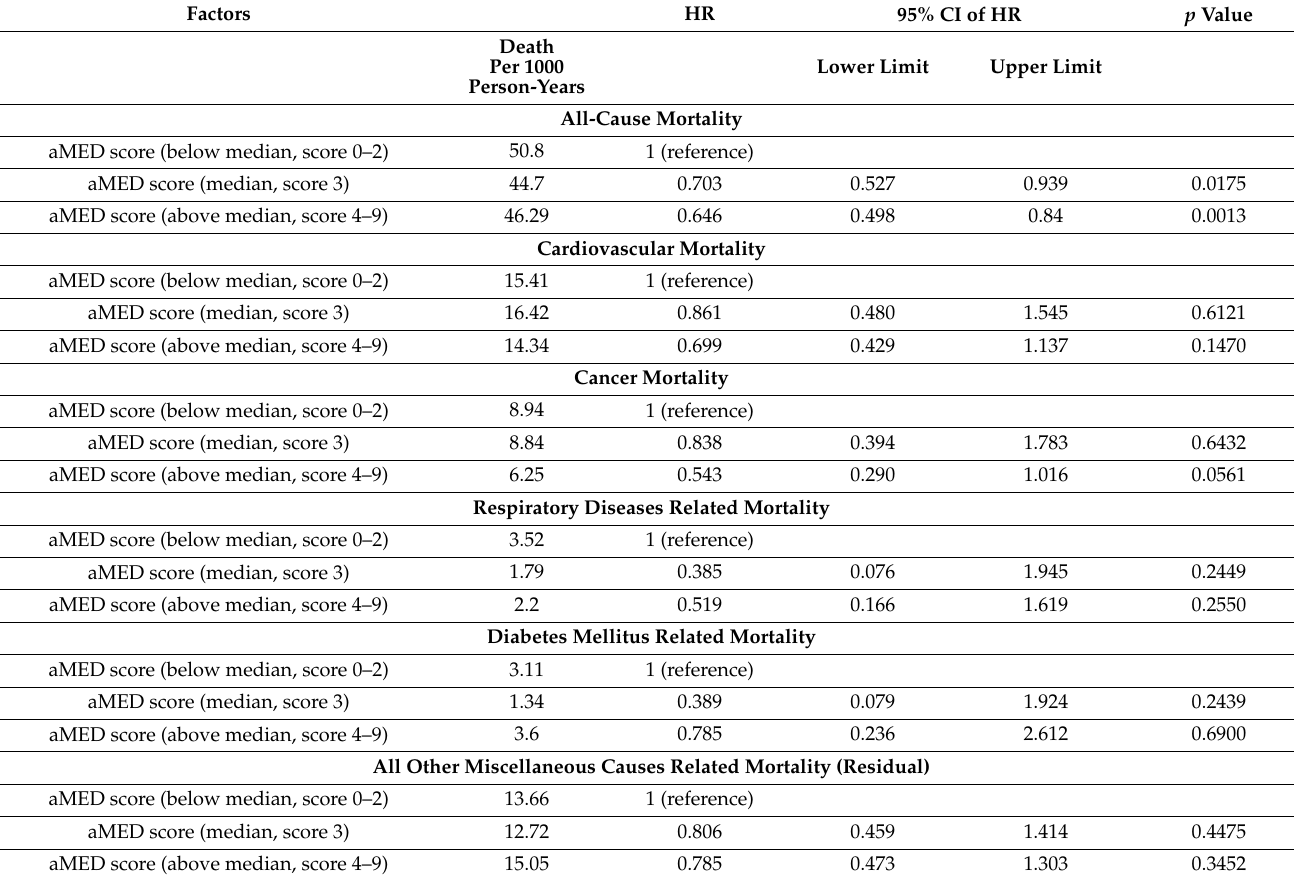
Table 2. Cox regression analysis of NHANES participants with a history of coronary heart disease or stroke for all-cause, cardiovascular, cancer, respiratory disease, diabetes mellitus and all other miscellaneous cause related